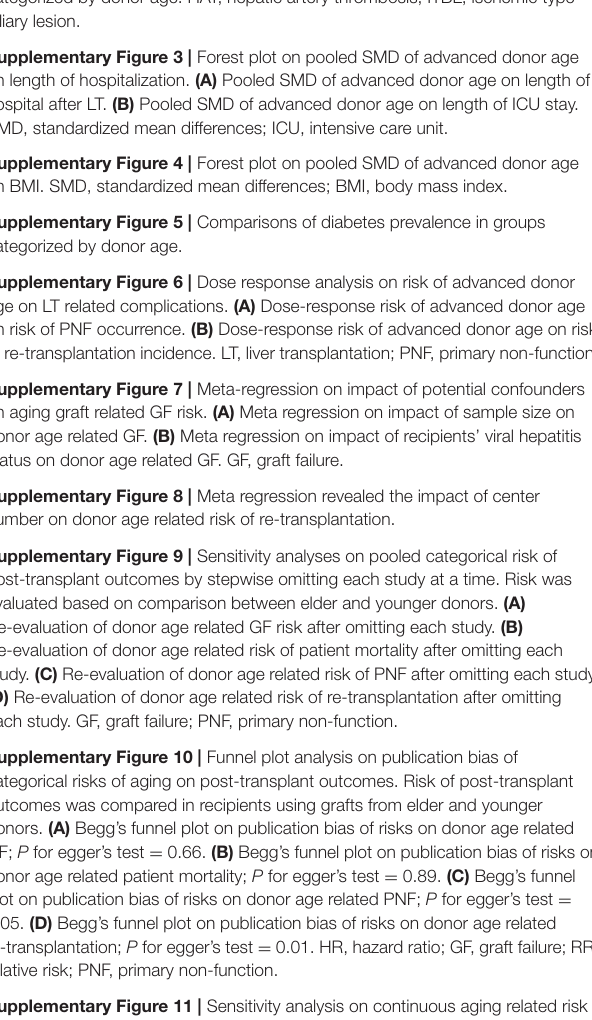
Supplementary Figure 1 | Graphical abstract of the study. Supplementary Figure 2 | Comparisons on HAT and ITBL occurrence in groups categorized by donor age. HAT, hepatic artery thrombosis; ITBL, ischemic type biliary lesion. Supplementary Figure 3 | Forest plot on pooled SMD of advanced donor age on length of hospitalization. (A) Pooled SMD of advanced donor age on length of hospital after LT. (B) Pooled SMD of advanced donor age on length of ICU stay. SMD, standardized mean differences; ICU, intensive care unit. Supplementary Figure 4 | Forest plot on pooled SMD of advanced donor age on BMI. SMD, standardized mean differences; BMI, body mass index. Supplementary Figure 5 | Comparisons of diabetes prevalence in groups categorized by donor age. Supplementary Figure 6 | Dose response analysis on risk of advanced donor age on LT related complications. (A) Dose-response risk of advanced donor age on risk of PNF occurrence. (B) Dose-response risk of advanced donor age on risk of re-transplantation incidence. LT, liver transplantation; PNF, primary non-function. Supplementary Figure 7 | Meta-regression on impact of potential confounders on aging graft related GF risk. (A) Meta regression on impact of sample size on donor age related GF. (B) Meta regression on impact of recipients’ viral hepatitis status on donor age related GF. GF, graft failure. Supplementary Figure 8 | Meta regression revealed the impact of center number on donor age related risk of re-transplantation. Supplementary Figure 9 | Sensitivity analyses on pooled categorical risk of post-transplant outcomes by stepwise omitting each study at a time. Risk was evaluated based on comparison between elder and younger donors. (A) Re-evaluation of donor age related GF risk after omitting each study. (B) Re-evaluation of donor age related risk of patient mortality after omitting each study. (C) Re-evaluation of donor age related risk of PNF after omitting each study. (D) Re-evaluation of donor age related risk of re-transplantation after omitting each study. GF, graft failure; PNF, primary non-function. Supplementary Figure 10 | Funnel plot analysis on publication bias of categorical risks of aging on post-transplant outcomes. Risk of post-transplant outcomes was compared in recipients using grafts from elder and younger donors. (A) Begg’s funnel plot on publication bias of risks on donor age related GF; P for egger’s test = 0.66. (B) Begg’s funnel plot on publication bias of risks on donor age related patient mortality; P for egger’s test = 0.89. (C) Begg’s funnel plot on publication bias of risks on donor age related PNF; P for egger’s test = 0.05. (D) Begg’s funnel plot on publication bias of risks on donor age related re-transplantation; P for egger’s test = 0.01. HR, hazard ratio; GF, graft failure; RR, relative risk; PNF, primary non-function. Supplementary Figure 11 | Sensitivity analysis on continuous aging related risk by stepwise omitting one study at a time. Risk was evaluated followed per 10-year of donor age increment. (A) Sensitivity analysis on continuous aging related GF risk by stepwise omitting one study at a time. (B) Sensitivity analysis on continuous aging related risk of patient death by stepwise omitting one study at